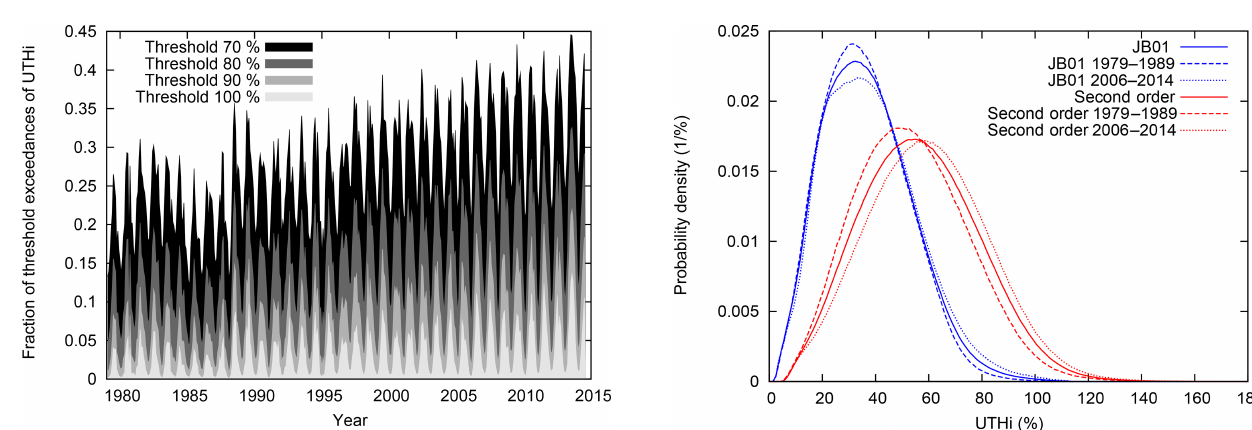
Figure 10. Probability density functions of UTHi retrieved with the formula of JB01 (using inter-calibrated brightness tempera- tures, blue) and with the second-order retrieval (using non-inter- calibrated brightness temperatures, red). Solid curves represent data from 1979 to 2014; dashed: data from 1979 to 1989; dotted: data from 2006 to 2014. We note that all curves have a similar shape but with the second-order retrieval, the pdf has a longer tail to high and supersaturated values. The upper tail is exponentially distributed in all pdfs shown. In both retrievals, the data show a tendency to higher UTHi values over the long observation